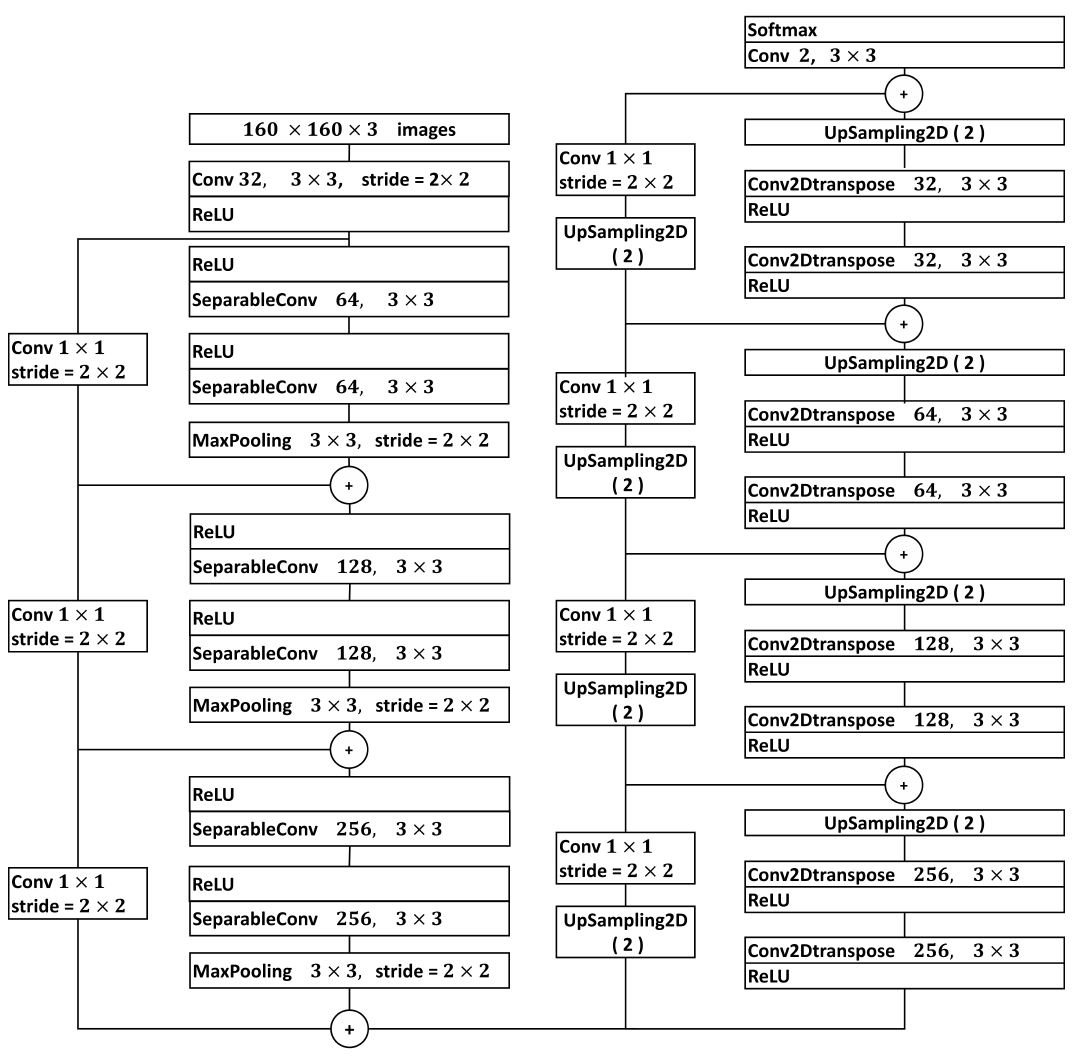
Figure 4. U-Net Xception-style